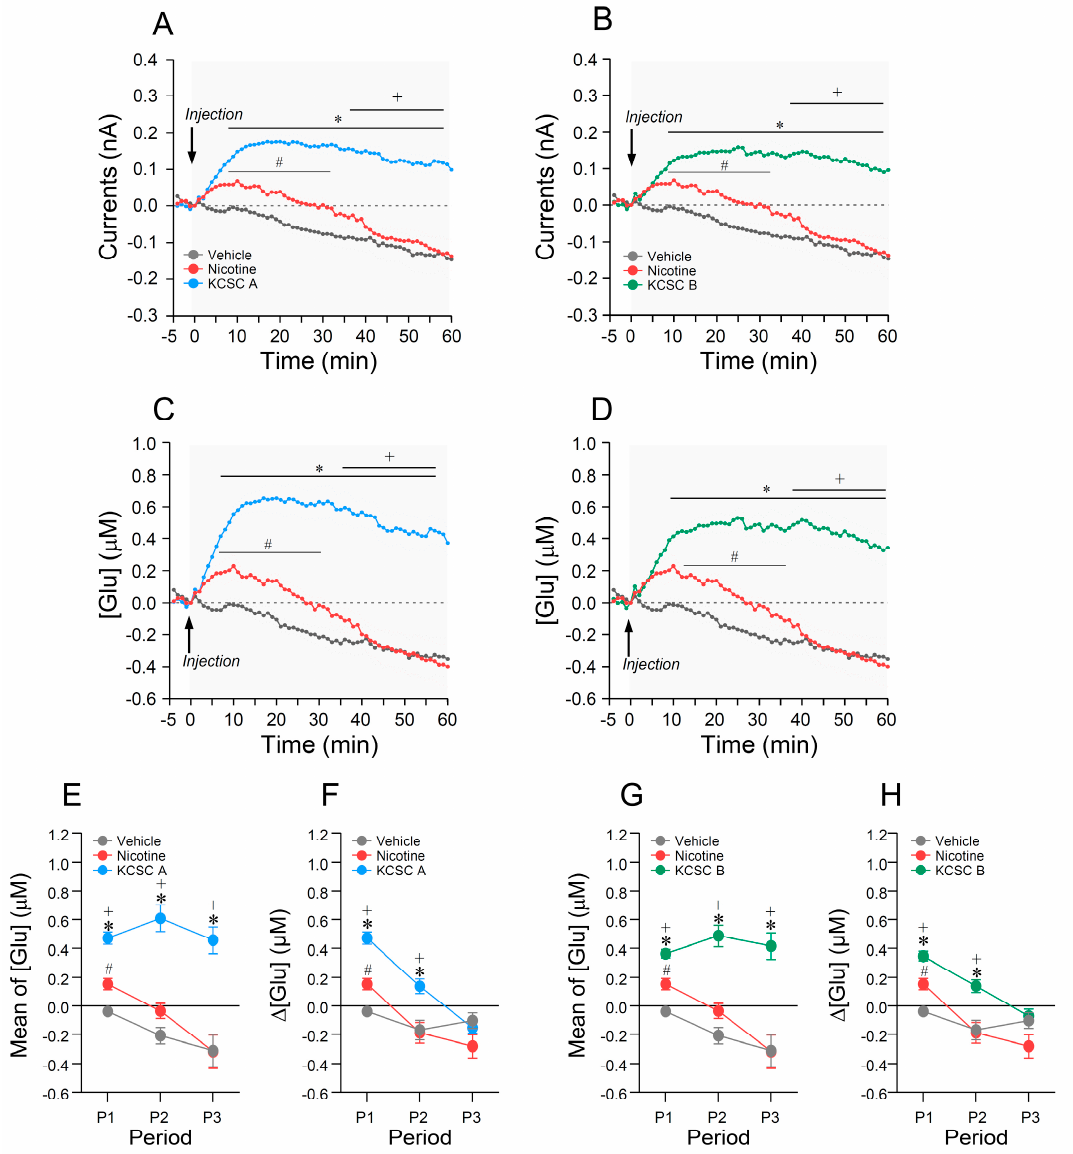
Figure 5. Changes in glutamate responses in the dorsal striatum after the repeated administration of two KCSCs using real-time glutamate biosensing. Statistical significance was determined by two-way RM-ANOVA and multiple comparison test with Bonferroni’s post-hoc test. # p < 0.05, repeated vehicle group vs. repeated nicotine group; * p < 0.05, repeated vehicle group vs. repeated KCSC groups; + p < 0.05, repeated nicotine group vs. repeated KCSC groups. n = 6 per